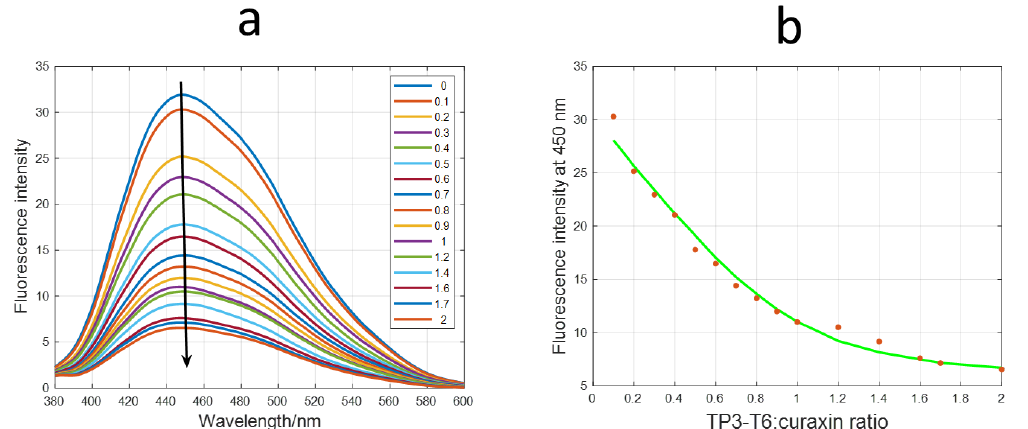
Figure 4 . ( a ) Fluorescence spectra recorded along the titration of curaxin with TP3-T6; ( b ) Experi- mental (red symbols) and calculated (green line) fluorescence intensity at 450 nm for the titration of curaxin at different concentrations of TP3-T6. Conditions: 20 mM phosphate buffer (pH 7.1), 70 mM KCl of 3 μM curaxin and increasing amounts of 69 μM of TP3-T6. Excitation wavelength 334 nm.